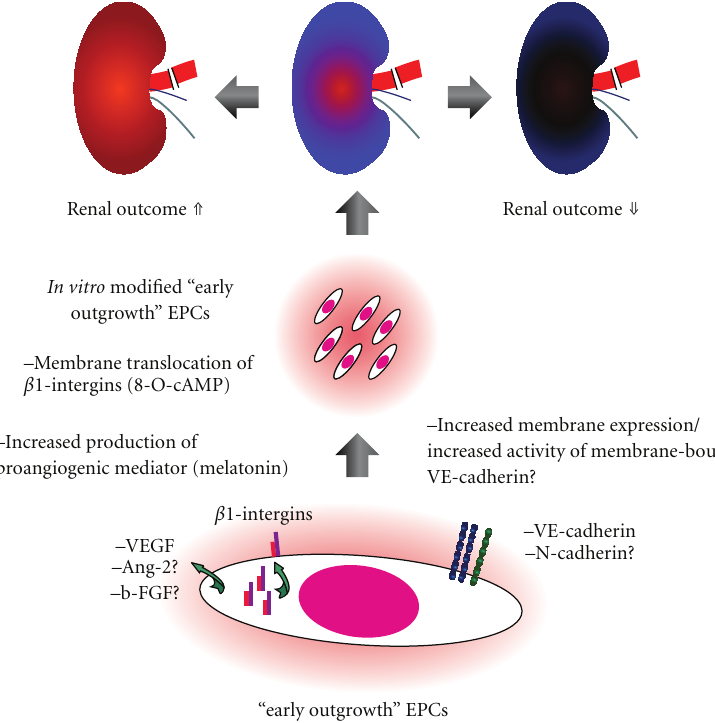
Figure 1: Mechanisms that are potentially involved in the stimulation or inhibition of EPC-mediated renoprotection after acute renal ischemia. Agonistic e ff ects on β 1-integrins, as they are induced by the Epac-1 activator 8-O-cAMP, increase renoprotective e ff ects of the cells by stimulating EPC homing to postischemic tissue sites. Another agonistic mechanism is increased production of vasostabilizing substances (e.g., VEGF) by the cells. Such increased production can be induced by cell pretreatment with the hormone melatonin.In contrast, inhibition of the VE- and N-cadherin system most likely results in decreased renoprotective competence of EPCs (for further explanation see